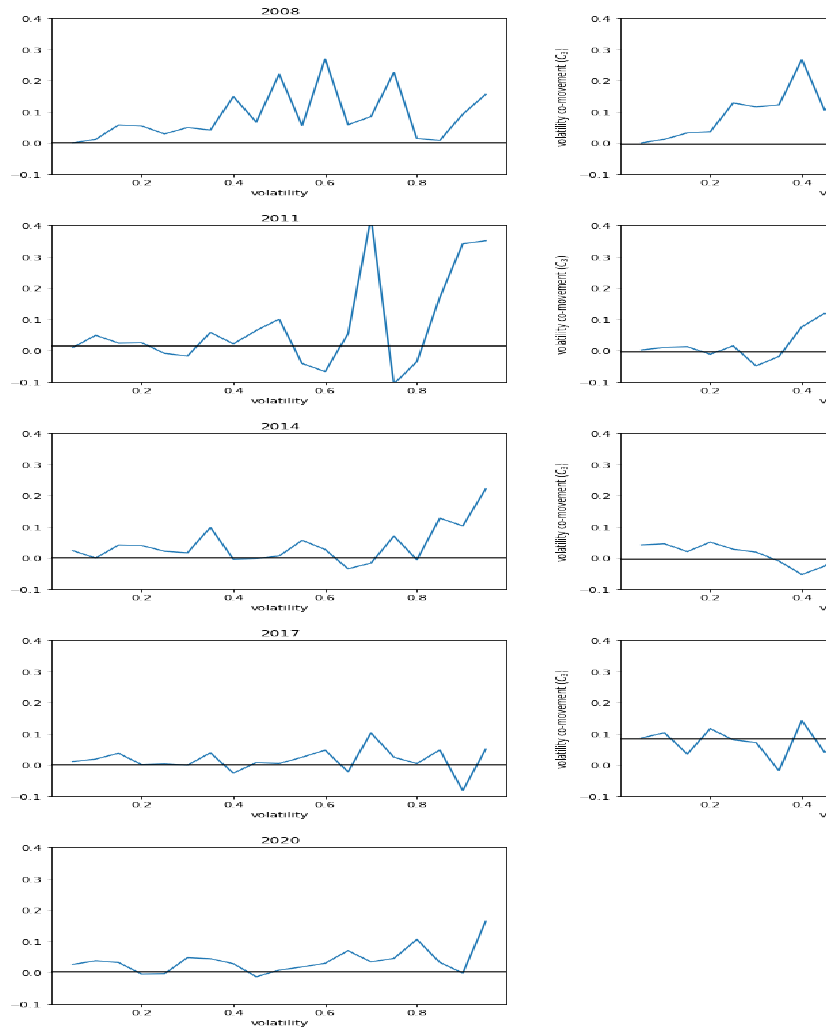
Scheme 5. Volatility monthly co-movement (subtracting the market) for each year in the period